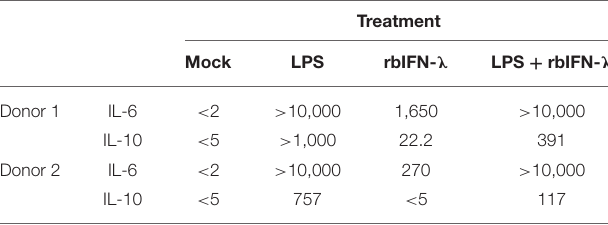
TABLE 4 | Effect of the bovine rIFN- λ on the induction of inflammatory responses in human immune cells.